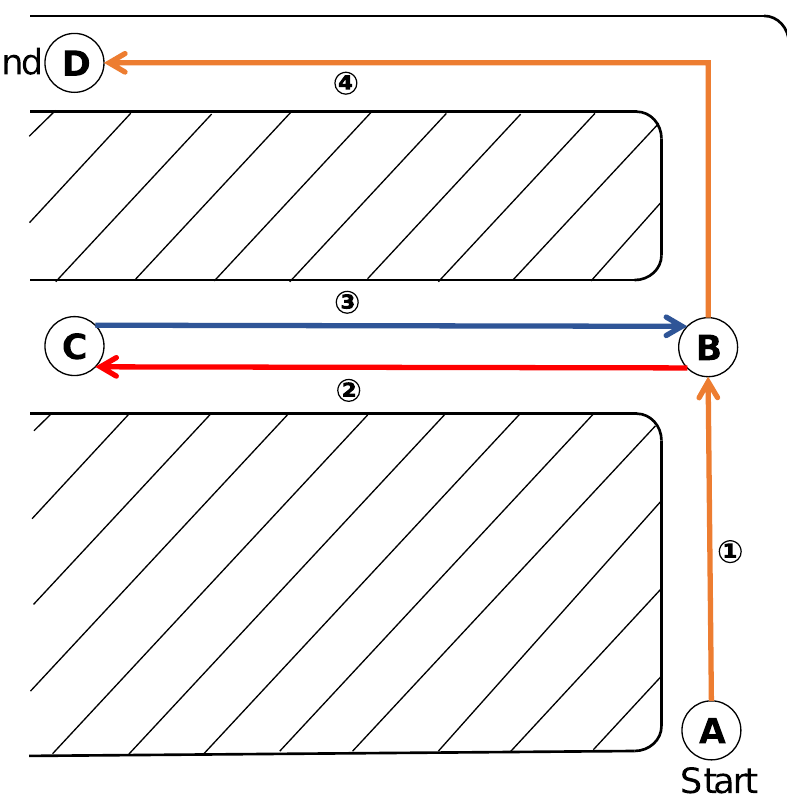
Figure 8. Incorrect route leading back. Path 1 and path 4 represent the correct navigation route, path 2 represents the incorrect route, and path 3 represents the leading back route.